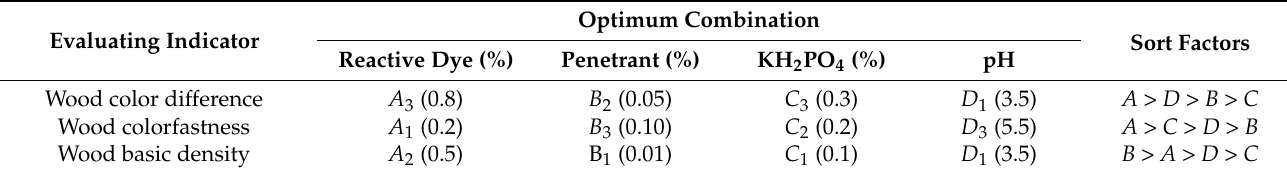
Table 8 lists the best process of dyeing and the evaluation index by color difference, colorfastness, and basic density. The results showed that the best level combination was different under each evaluation index. Table 8. The best combination of dyeing solutions under different evaluation indexes and the order of four factors. Evaluating Indicator Wood color difference Wood colorfastness Wood basic density